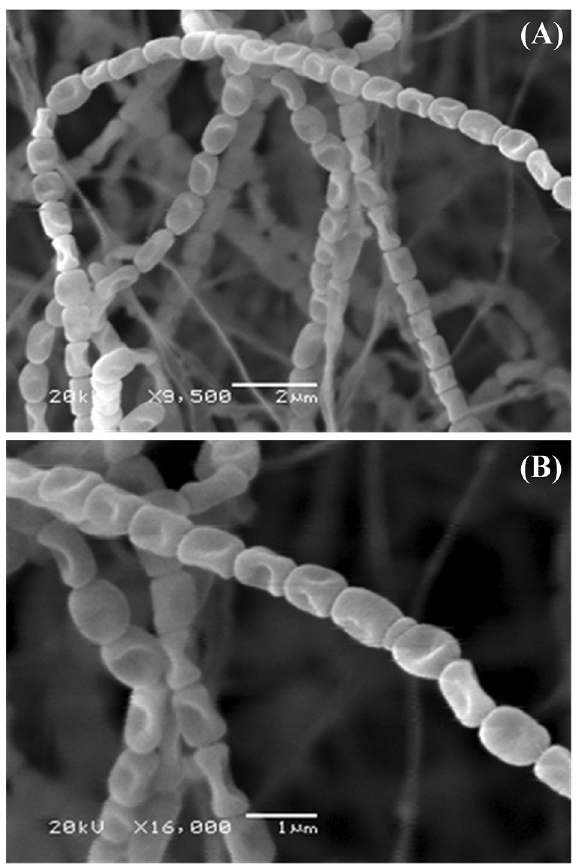
Figure 3. The ornamentation of the spore-chain morphology and spore-surface of Streptomyces sp. strain NEAE-83 at the magnification of ×9500 ( A ) and ×16,000 ( B ), as detected by scanning electron